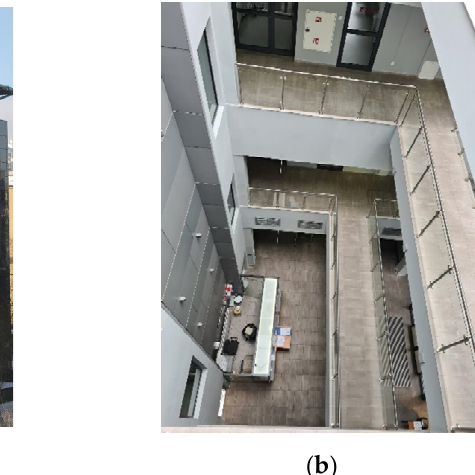
Figure 6. LabFactor building and its atrium space: ( a ) external building view; ( b ) the atrium in the building (photograph courtesy of Brzezi ń ska).